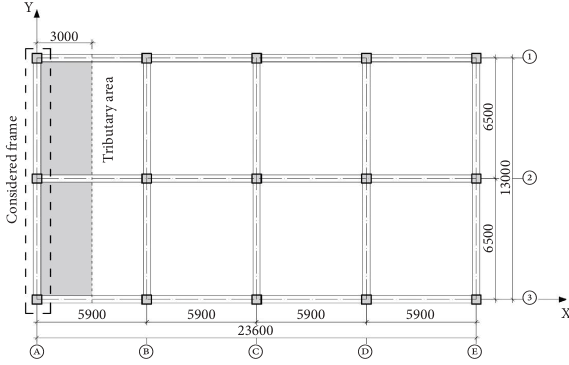
Figure 3: Plan view of the RC ofce